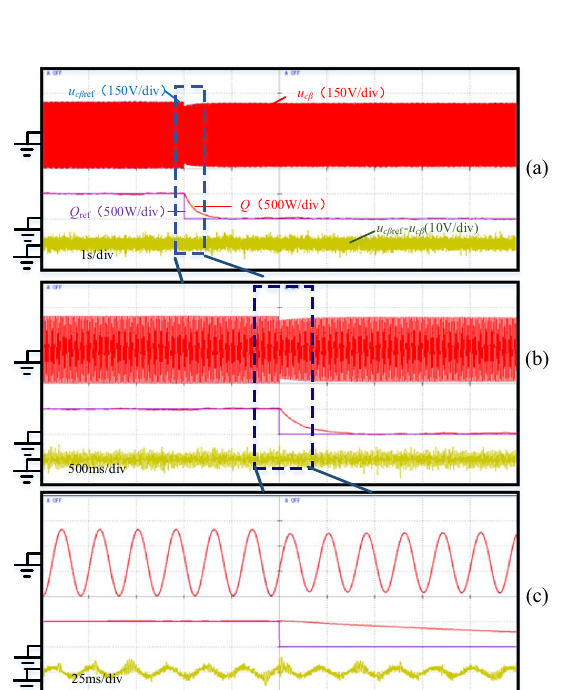
Fig. 11 Experimental waveforms during sudden change of